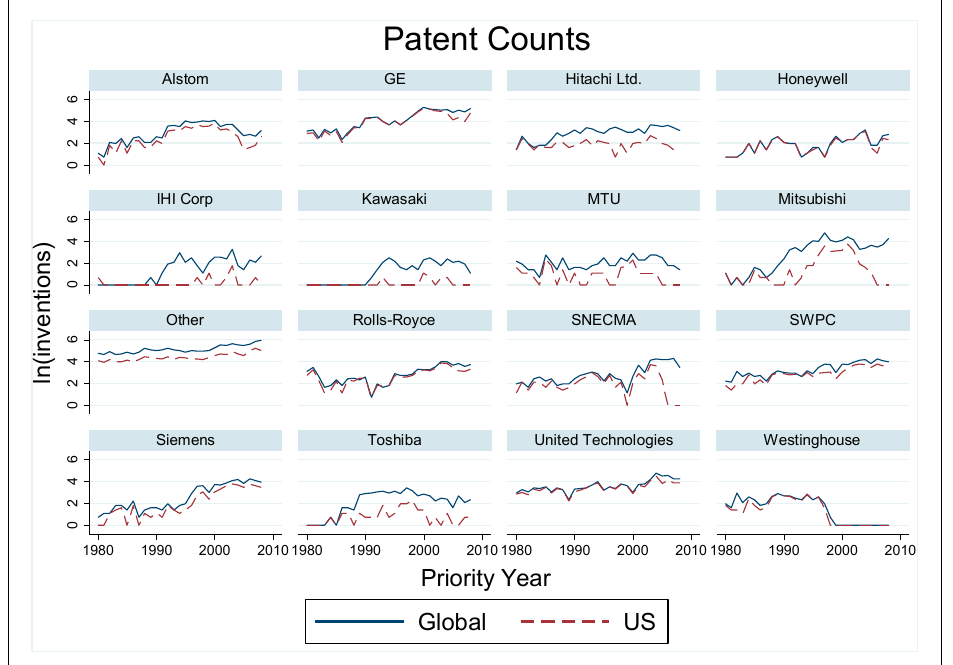
Figure 3. Patent counts (inventions) for unique ATS inventions filed in the U.S. and elsewhere (Global)